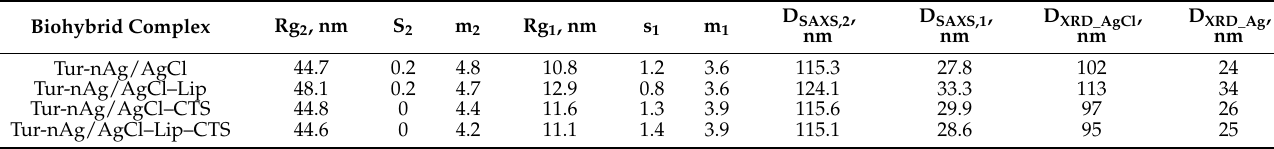
Table 1. Structural parameters derived from the analysis of SAXS and XRD data of the silver/silver chloride nanoparticles for biohybrid complexes. The D XRD is the average crystallite size and D SAXS, i = 2(5/3) 1/2 R g, i is an average diameter of